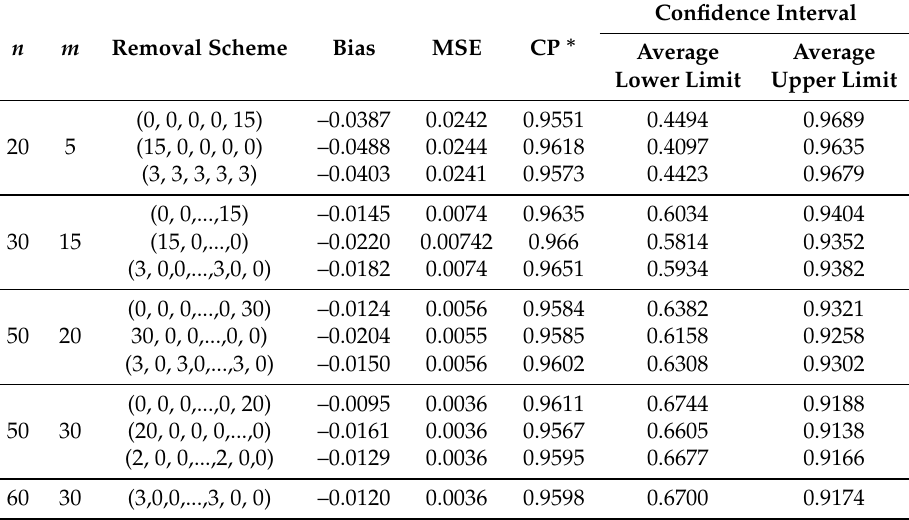
Estimation results of δ s , k using the parametric percentile bootstrap method